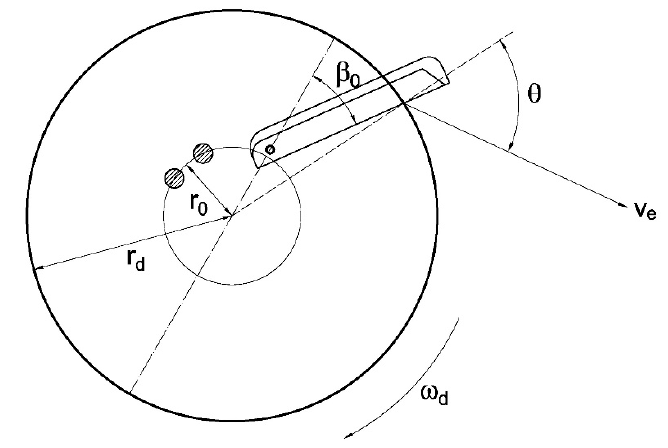
Figure 2. Geometry, kinematics, and dynamics of a spinning disc Figure 1. Geometry, kinematics, and dynamics of a spinning disc fertilizer.